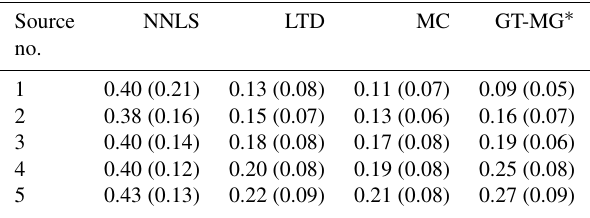
Table 1. Mean and standard deviation of the nearness.